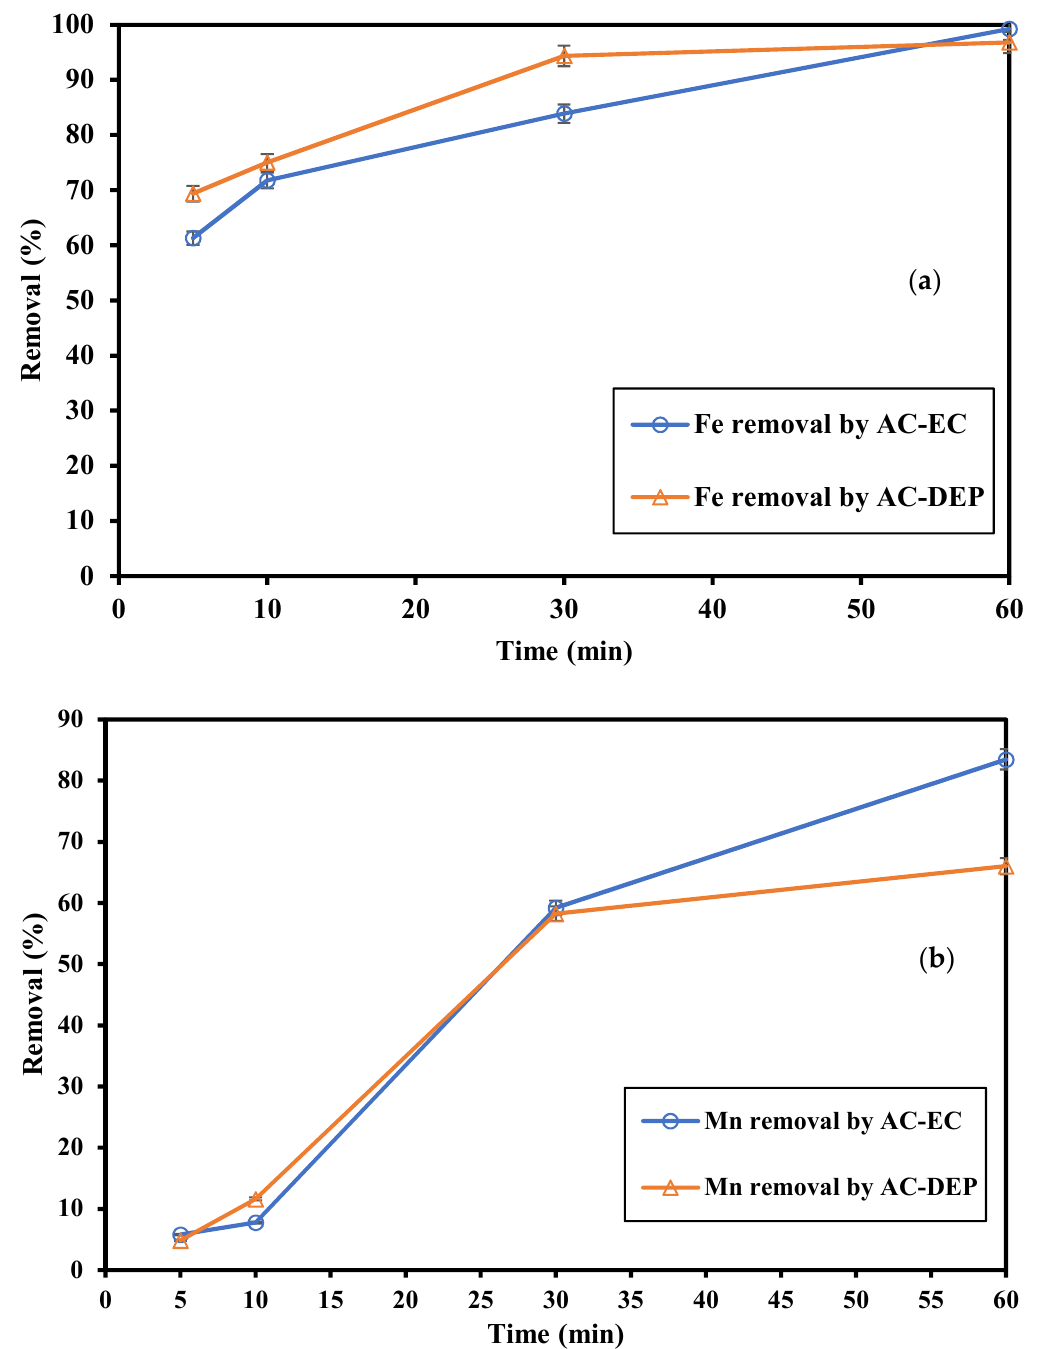
Figure 8. The removal percentage of Fe and Mn using variable electrolysis time, electrode spacing 0.5 cm and applied current 800 mA. ( a ) Fe removal percentage; ( b ) Mn removal percentage.